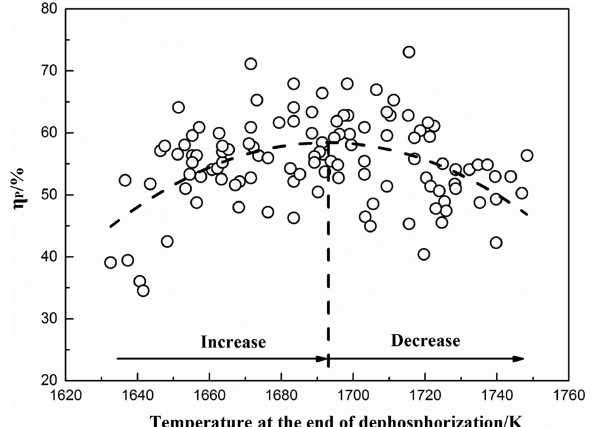
Figure 4: Relationship between dephosphorization reaction equili- brium constant and